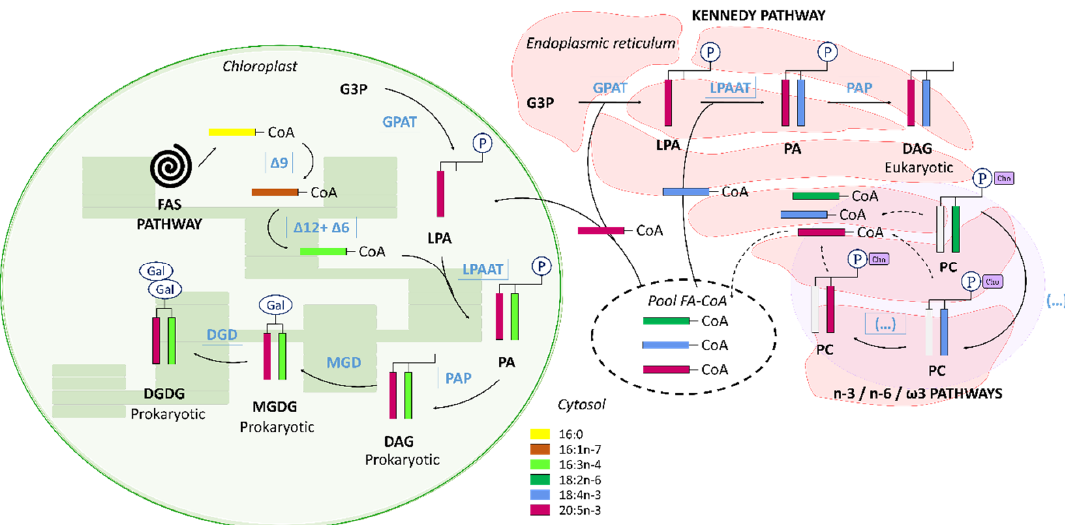
Figure 13. Hypothesized pathway for the production of prokaryotic glycolipids in C. muelleri . Two pathways can produce DAG: one is located in the chloroplast ( prokayotic pathway ), the other in the endoplasmic reticulum (ER) ( eukaryotic pathway ). The 20:5n-3-CoA used for glycolipids synthesis is produced in the ER and collected from it to form prokaryotic DAG. This DAG can be further used to create glycolipids (configuration sn-1 : 20:5n-3 and sn-2 : 16:3n-4). The eukaryotic pathway in the ER could